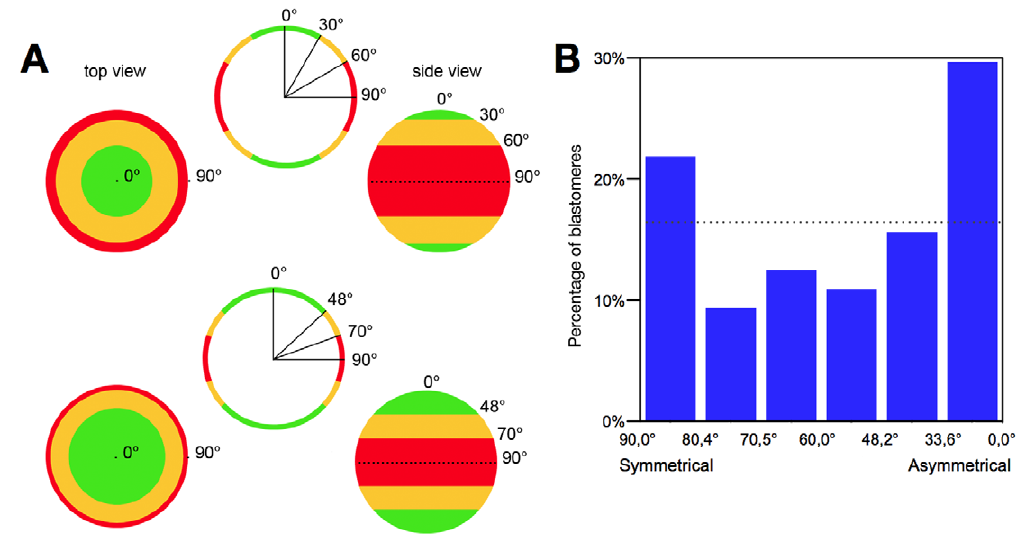
Figure 5. Spindle orientation in 8-cell stage embryos. A: Schematic representation of the probability of spindle orientation distribution. Since the spindle can orient in a 3D space, and not on a 2D plane, the probability for the spindle to be in a given range of angles is proportional to a «stripe» of the surface of a sphere. Therefore, this probability is proportional to cosine ( a ) rather than to a itself. This is illustrated on these three colours balloons, viewed from the top and the side. If the ranges are proportional to a , then the surfaces covered by each of the three colours are different (top). When the ranges are proportional to cosine ( a ), each colour covers the same area of the surface (bottom). B: Distribution of a according to cosine ( a ): the cosine of the angles (X axis) shown corresponds to multiple of 0.166 (since cosine ( a ) varies between 0 and 1). The Y axis corresponds to the percentage of spindle oriented with a given angle. A non-random distribution is observed, with an increase for the two extreme ranges suggesting that spindle orientation is not completely random. The dash line corresponds to the expected percentage for each ‘‘ a ’’ angle value if the spindle orientation was random.